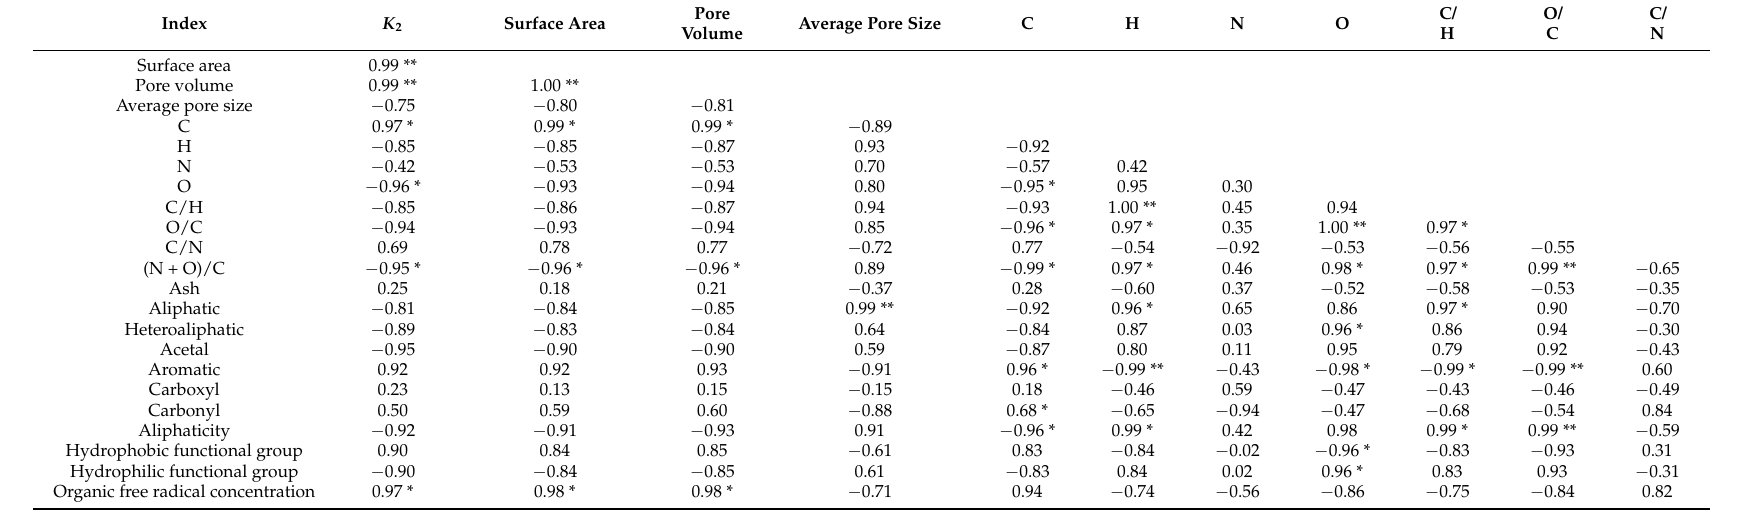
Table 5. Correlation coefficient of the adsorption rate constants and the structural characteristics of